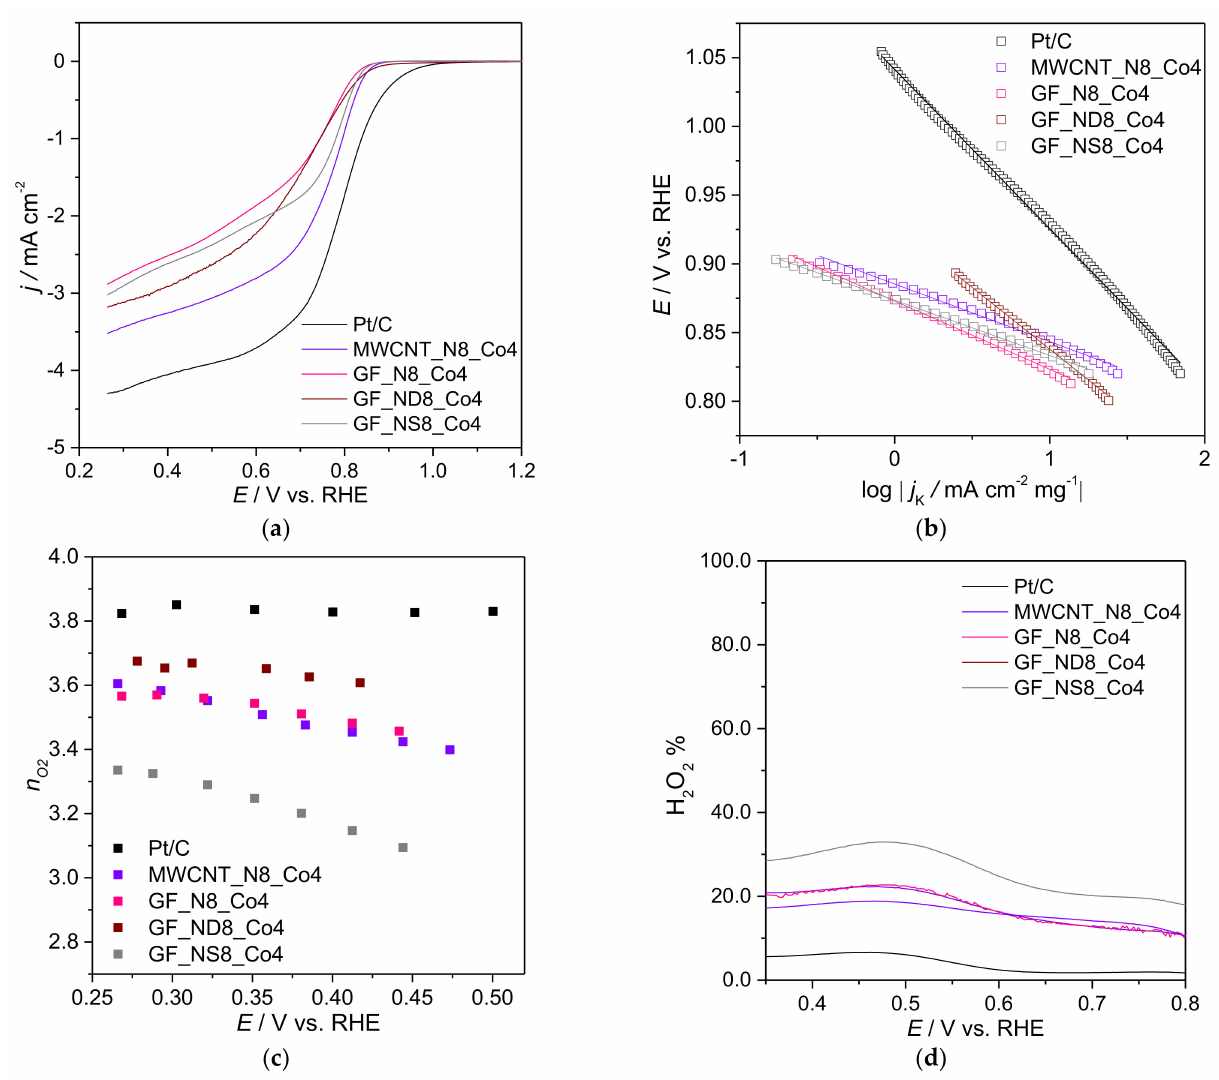
Figure 8. ORR LSV curves obtained in KOH (0.1 M) saturated with O 2 for Pt/C, MWCNT_N8_Co4, GF_N8_Co4, GF_ND8_Co4, and GF_NS8_Co4 at 1600 rpm and 0.005 V s − 1 ( a ), the corresponding ORR Tafel plots ( b ), n O at several potential values ( c ), and the estimated percentage of H 2 O 2 2 produced ( d ). Table 4. Electrocatalytically active surface area (ECSA) values of the doped-CM and the